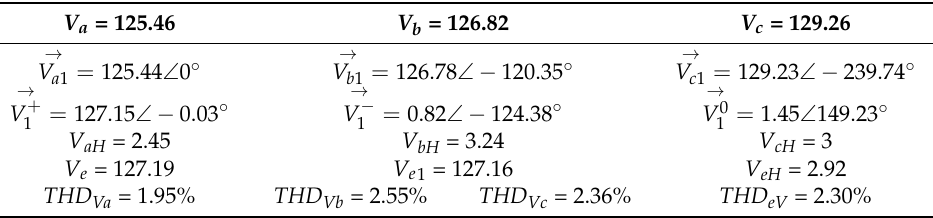
Table 3. Main voltage magnitudes at pcc (in volts).